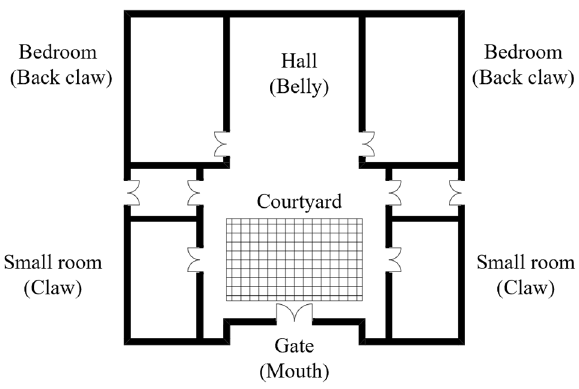
Figure 1. Archaic “climbing lion” rammed earth house.